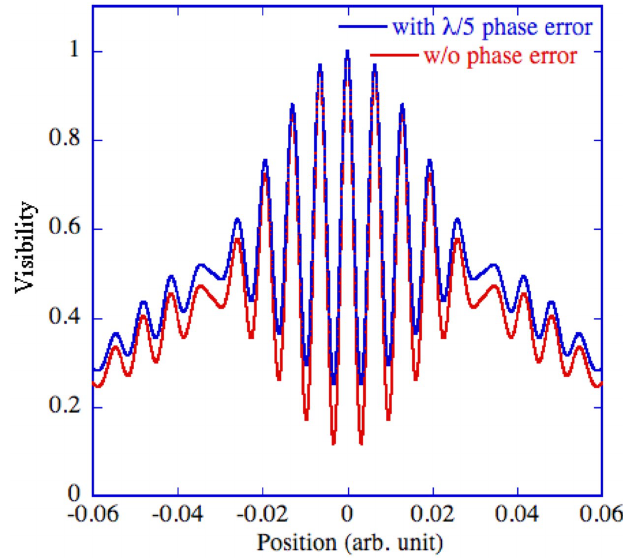
FIG. 3. (Color) Results of interferogram simulations. The green line shows the case of a 5 (cid:1) m beam size without phase error, and the red line shows the case of a 5 (cid:1) m beam size with a phase error of (cid:6)= 5 .